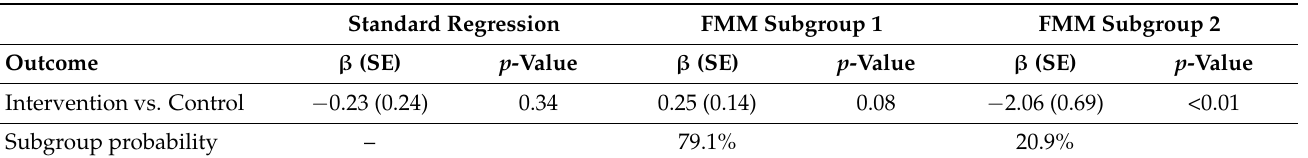
Table 3. Regression and finite mixture model (FMM) results estimating the impact of the intervention on delay discounting at